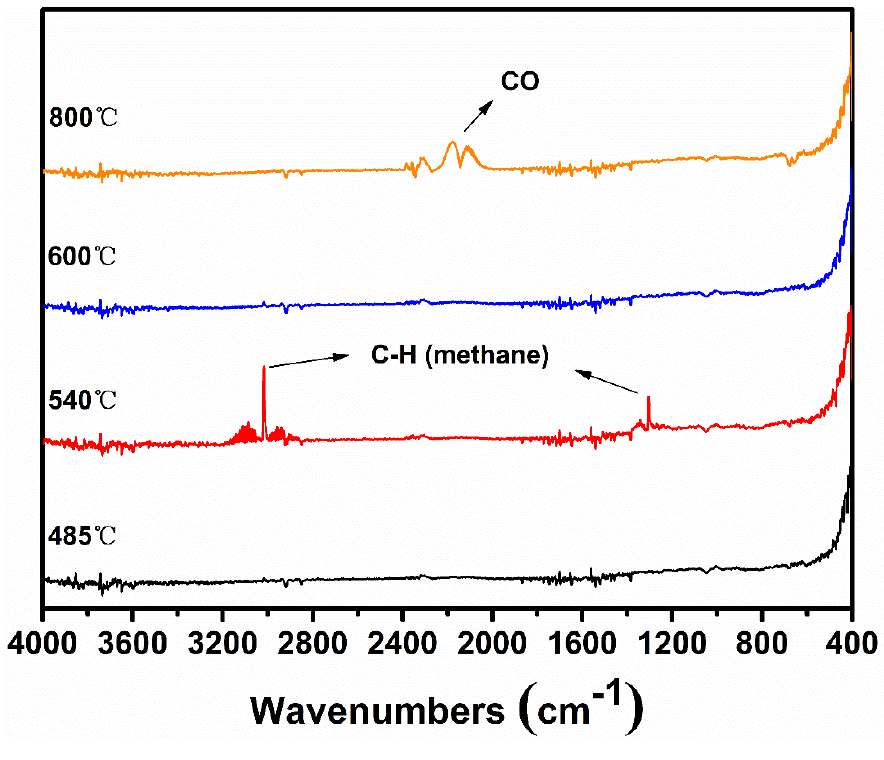
Figure 7. FTIR spectra of gaseous products of sodium p- cresolate at selected temperatures.